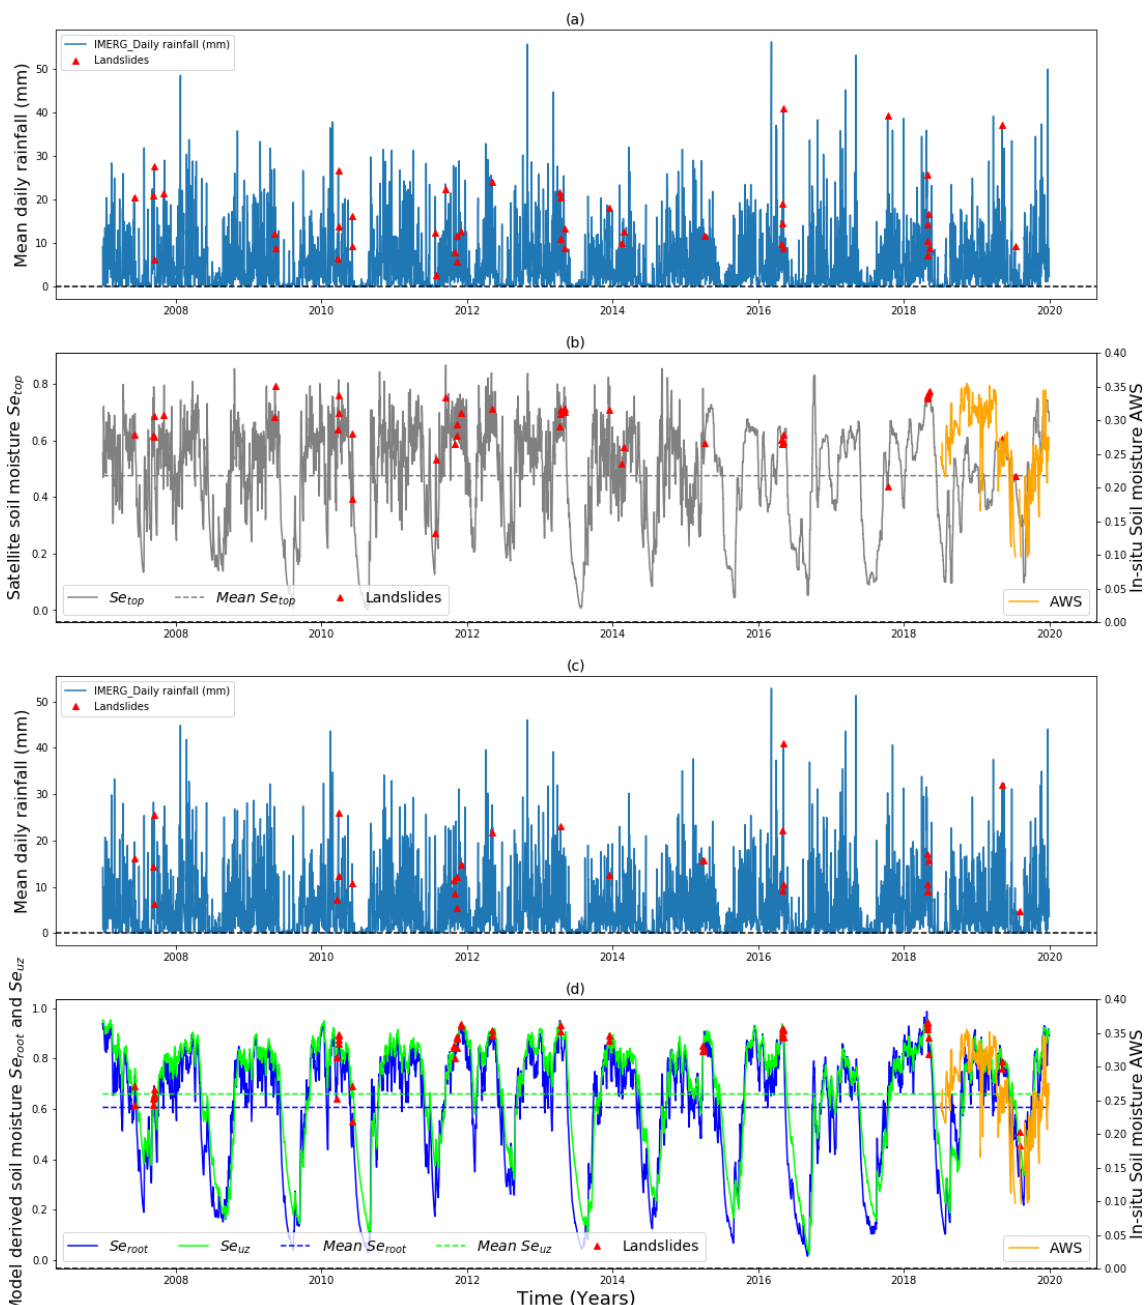
Figure 5. Satellite- and model-derived information and landslide activities: (a) GPM-based IMERG precipitation (mm) spatially averaged over all landslide precipitation footprints; (b) satellite-derived soil moisture Se top (–) spatially averaged over all landslide ROIs and in situ soil moisture AWSs (–) on the secondary y axis; (c) GPM-based IMERG precipitation (mm) spatially averaged over the landslide precipitation footprints located in the modelled catchments; (d) modelled soil moisture at the root zone top 50cm Se root (–), modelled soil moisture top 2m Se uz (–) and in situ soil moisture AWS (–) on the secondary y axis. The dashed horizontal lines represent the long-term mean soil moisture and the red triangles stand for the landslide